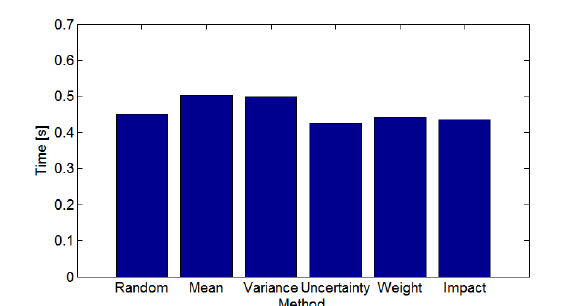
Figure 6. The calculation time needed for active learning with Gaussian